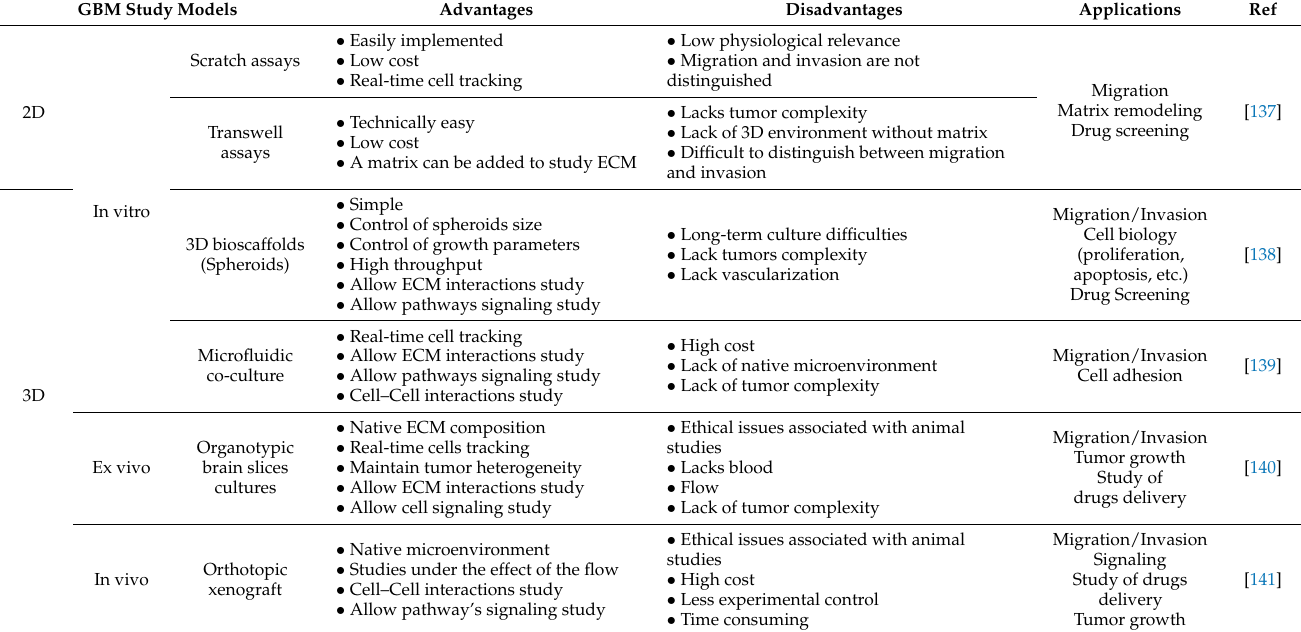
Table 2. Advantages and disadvantages of different models used in the study of